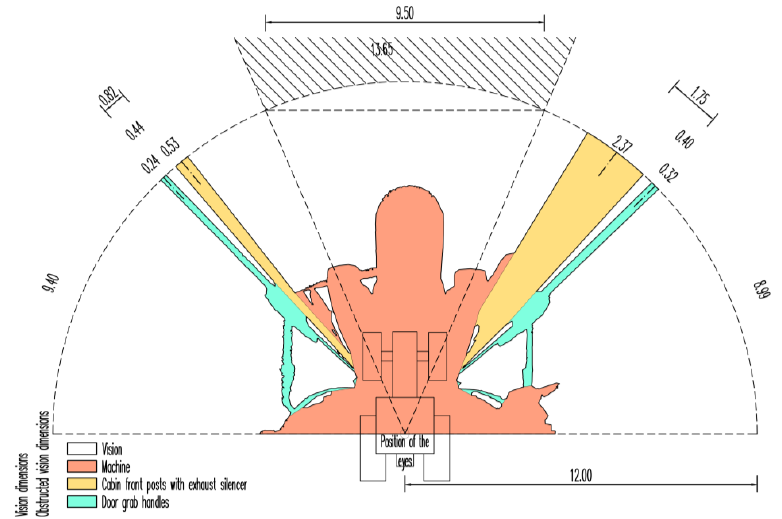
Figure 5. Semi-circular vision to the front of agricultural tractor driver determined by the TLS method. Note: dimensions are in m.